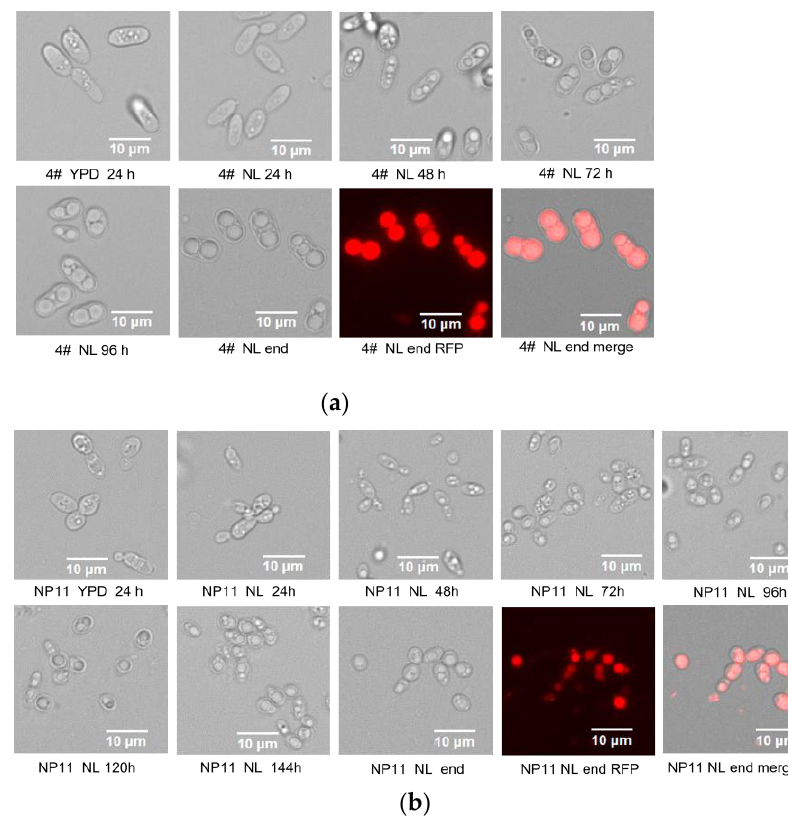
Figure 3. Microscope photos of R. toruloides NP11 and 4# cells during lipid production culture. ( a ) The diploid strain R. toruloides 4# cells during the culture and those at the end of the culture being treated by Nile Red. ( b ) The haploid strain R. toruloides NP11 cells during the culture and those at the end of the culture being treated by Nile Red. NL, nitrogen-limited culture. RFP, red fluorescence module of the microscope.